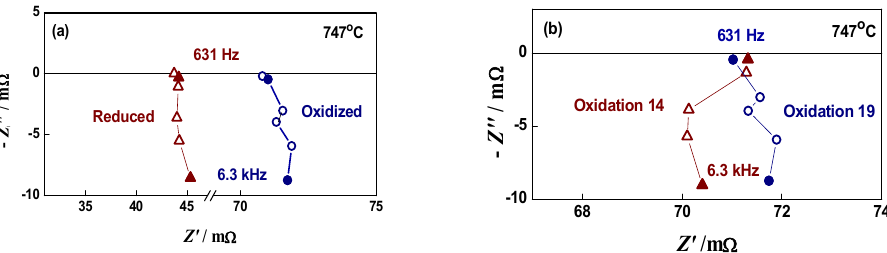
Figure 3. Impedance diagrams of bare anode during “soft” redox cycling (2 times increase in R Ni network ): ( a ) reduced and oxidized state of bare anode; ( b ) two oxidized states of bare anode.